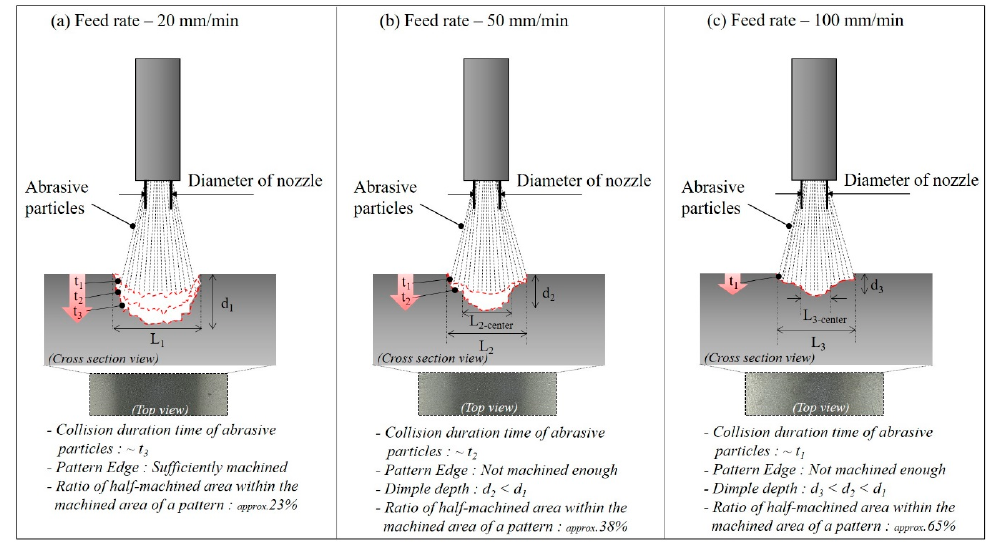
Figure 13. Pa tt ern shape change mechanism according to the nozzle traverse speed of AAJ pro- Figure 13. Pattern shape change mechanism according to the nozzle traverse speed of AAJ processing cessing (at 300 Mpa). (at 300